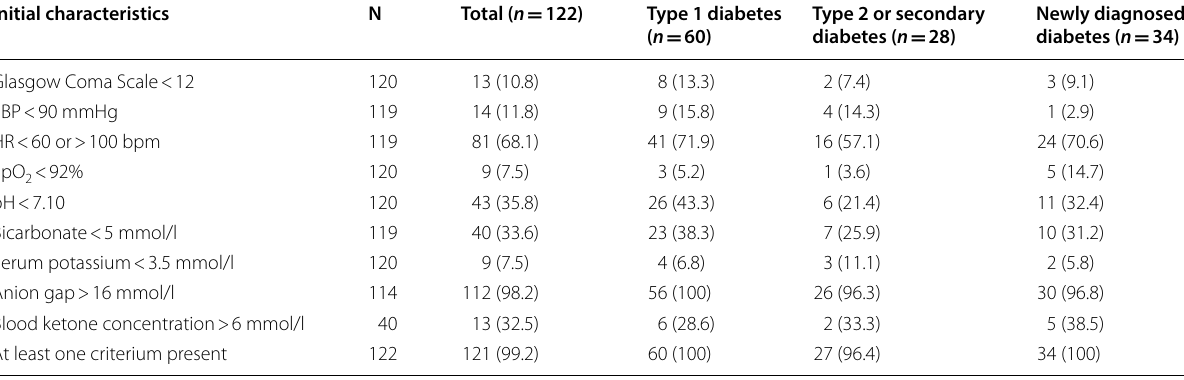
Data are presented as the n